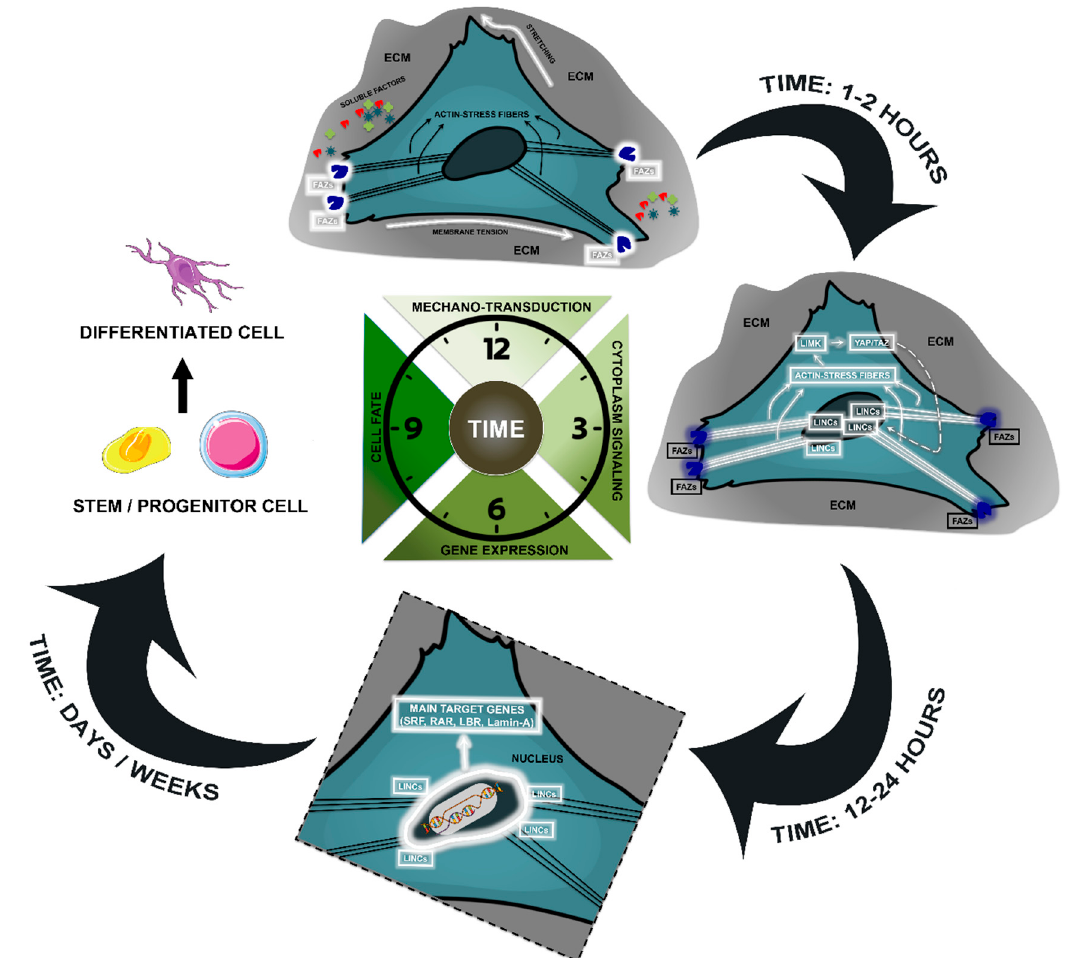
Figure 1. Mechanotransduction converts mechanical stimuli into biochemical signals to modulate cell behavior and function. Generally, the pathways involve receptors at the focal adhesions, mechanosensors, nuclear signaling factors, and nuclear deformation mediated by LINCs and Laminin A, leading to the modulation of gene expression. These phases’ timescale ranges from seconds for the stretching of mechanosensors, hours for alteration in gene expression, days for modification in cell behavior and function, while severe and permanent changes in phenotype, such as di ff erentiation, require